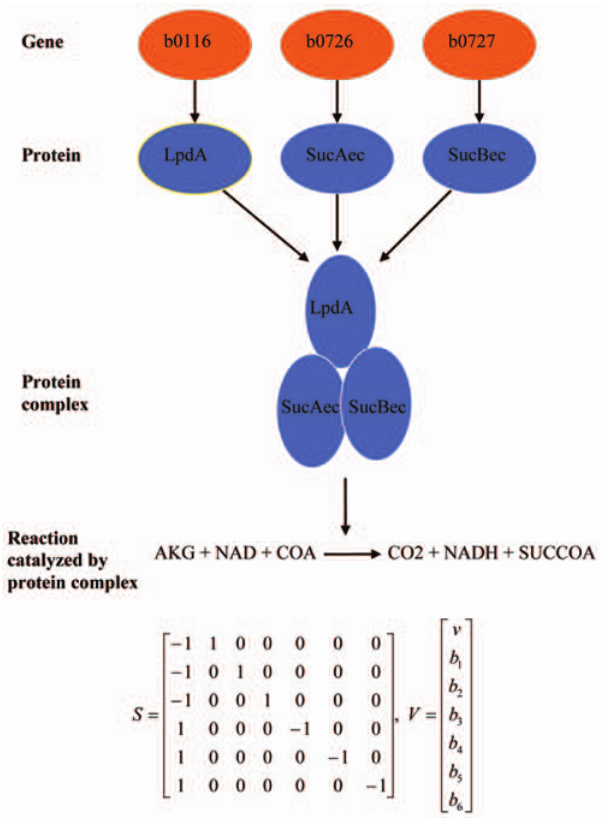
Figure 1. An example of the interaction rules found in the E.coli metabolic network. The protein products of the genes b0116, b0726, and b0727 combine to form a protein complex that catalyzes production of succinate coenzyme A (SUCCOA) from alpha-ketogluta- rate (AKG) and coenzyme A, with the concomitant reduction of nicotinamide adenine dinucleotide (NAD) and release of carbon dioxide (CO 2 ). A matrix S of the stoichiometries of the reactants, and a vector V of fluxes are shown. v , b 1 , b 2 , b 3 , b 4 , b 5 , and b 6 denote the rates of the above reaction, the production of AKG, NAD, and COA, and the utilization of CO 2 , NADH, and SUCCOA, respectively (Note that this is a simplification of the way the reaction is actually represented in our model). At steady state S ? V =0. In the event that one of the genes catalyzing the above reaction is turned off by mutation, the reaction flux v is set to 0. Abbreviations (gene/protein product): b0116/LpdA, dihydrolipoamide dehydrogenase; b0726/SucAec, alpha-ketoglutarate decarboxylase; b0727/SucBec, dihydrolipoamide